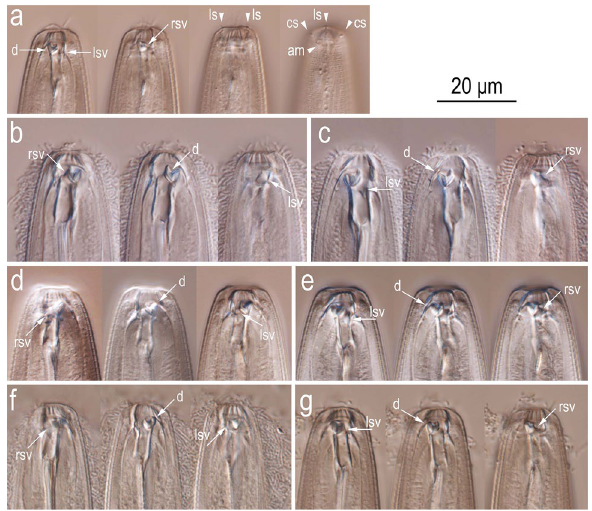
Figure 5. Light micrographs of stomatal region of Onthodiplogaster japonica n. gen., n. sp. ( a ) Right lateral view of male from fungal culture in four different focal planes; ( b,c ) left ( b ) and right ( c ) lateral views of predating female in three different focal planes; ( d,e ) left ( d ) and right ( e ) lateral views of bacteria feeding female in three different focal planes; ( f,g ) left ( f ) and right ( g ) lateral views of fungal feeding female in three different focal planes. Labels are as follows: am = amphid; cs = cephalic sensilla; d = dorsal tooth; lsv = left subventral ridge; ls = labial sensilla; rsv = right subventral